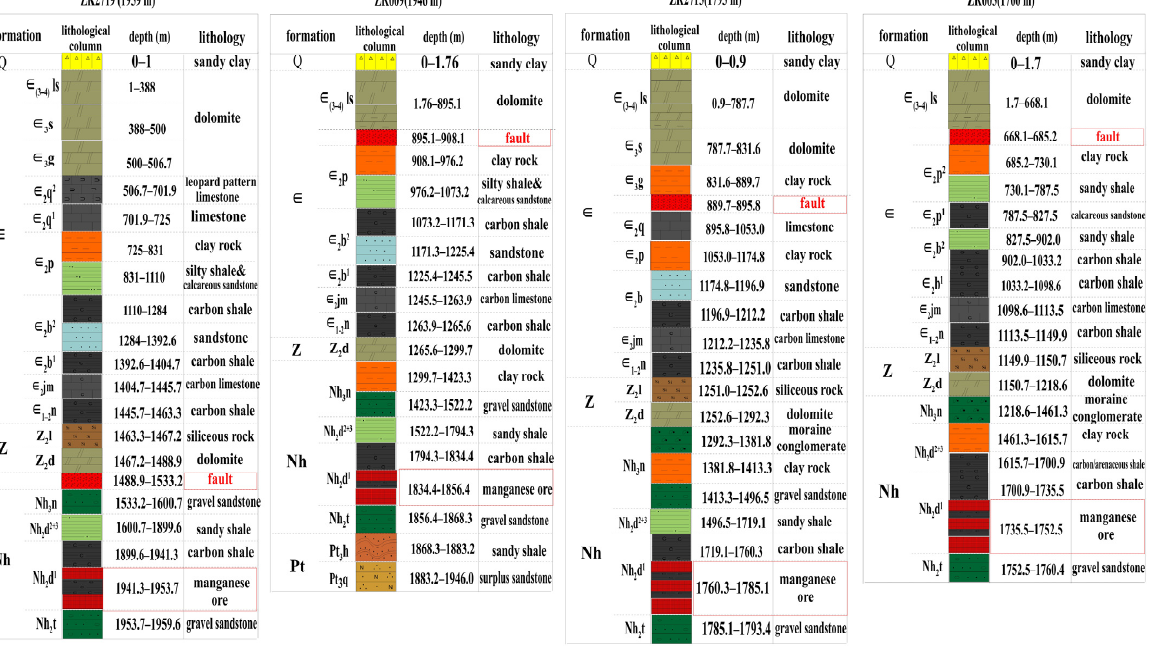
Figure 5. Lithological column and formation thickness at 4 boreholes. The banded black and red formations indicate carbon shale containing manganese ore layers. Table 1. Resistivity of rock samples in the study area (the rock samples were collected from the borehole rocks in Figure A3). Rock